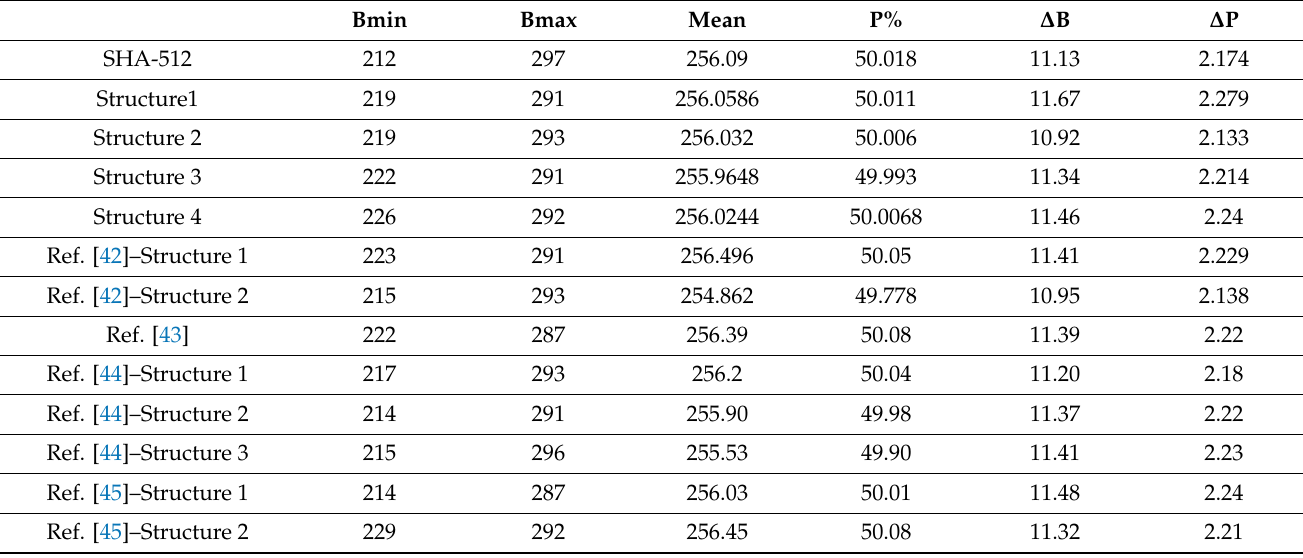
Table 8. Confusion and diffusion test results for 1000-message tests.